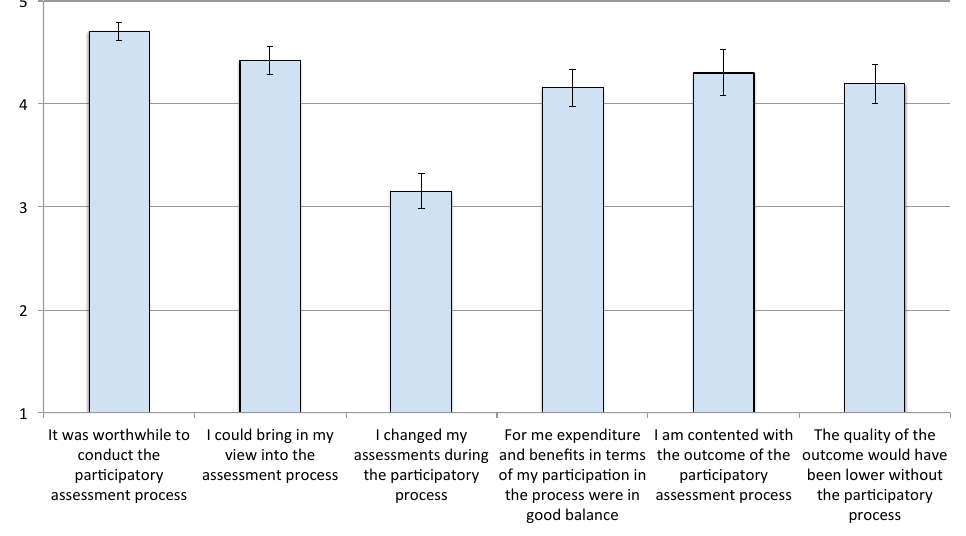
Figure 8: Evaluation (T2, N=25) after the participatory assessment process. Participants assessed the criteria on a 6-point scale (1= ‘fully insufficient’ to 6= ‘very sufficient’)